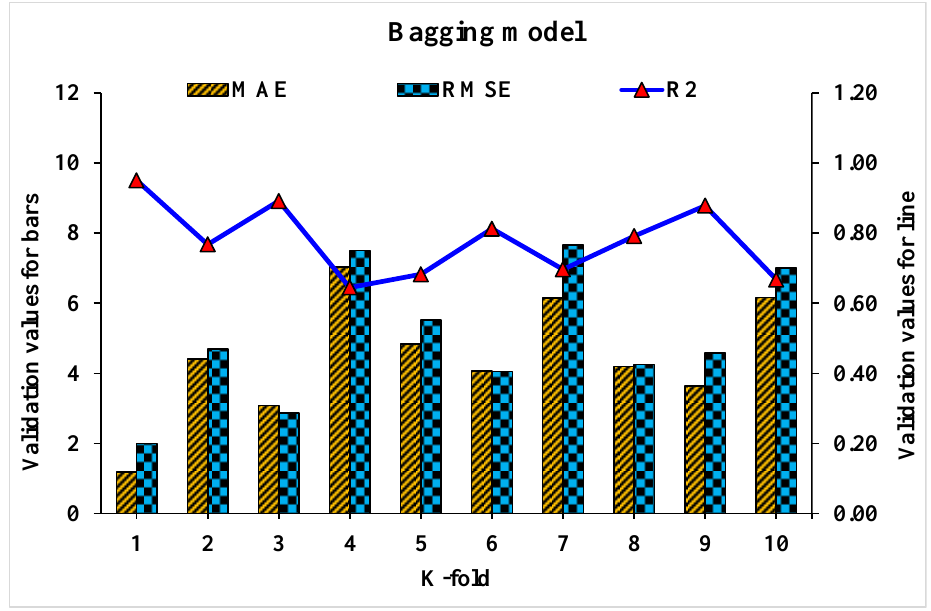
Figure 21. Statistical analysis of bagging model for K-fold cross-validation.